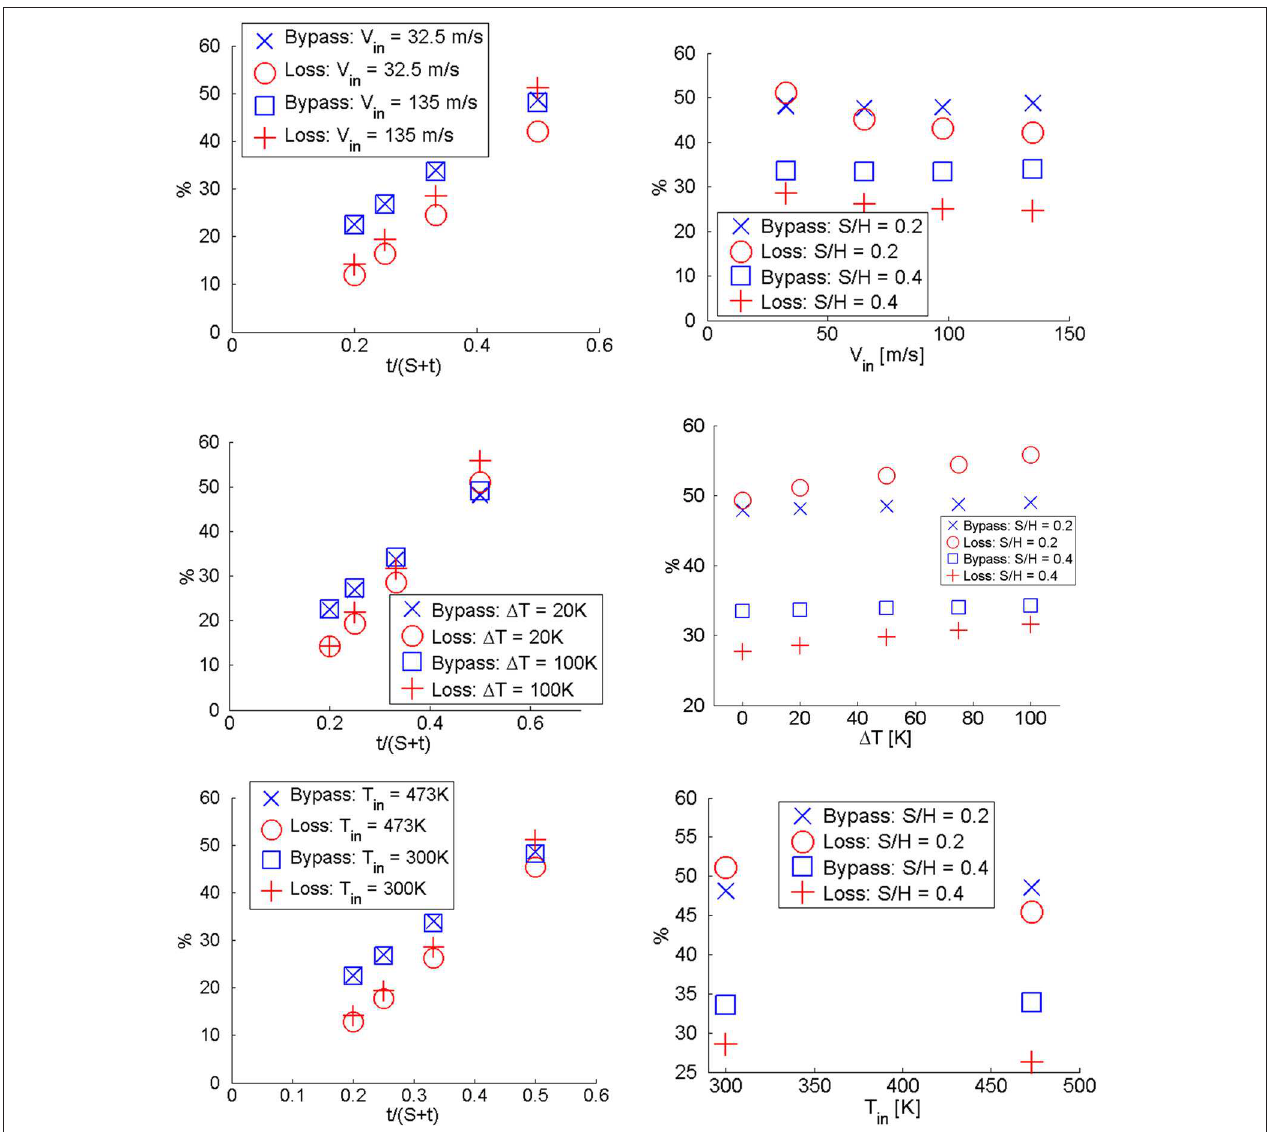
FIGURE 10 | Effects of S/H, T in , 1 T, V in on bypass and loss. Top: V in (Left: cases 14, 17, 26, 29, 30, 32, 34, 35. Right: cases 14–17, 22–25). Mid: 1 T (Left: cases 14, 21, 22, 29, 30–33. Right: cases 14, 18–21, 22, 26–29). Bottom: T in (Left: cases 4, 7–9, 17, 25, 34, 35. Right: cases 7, 8, 17, 25).